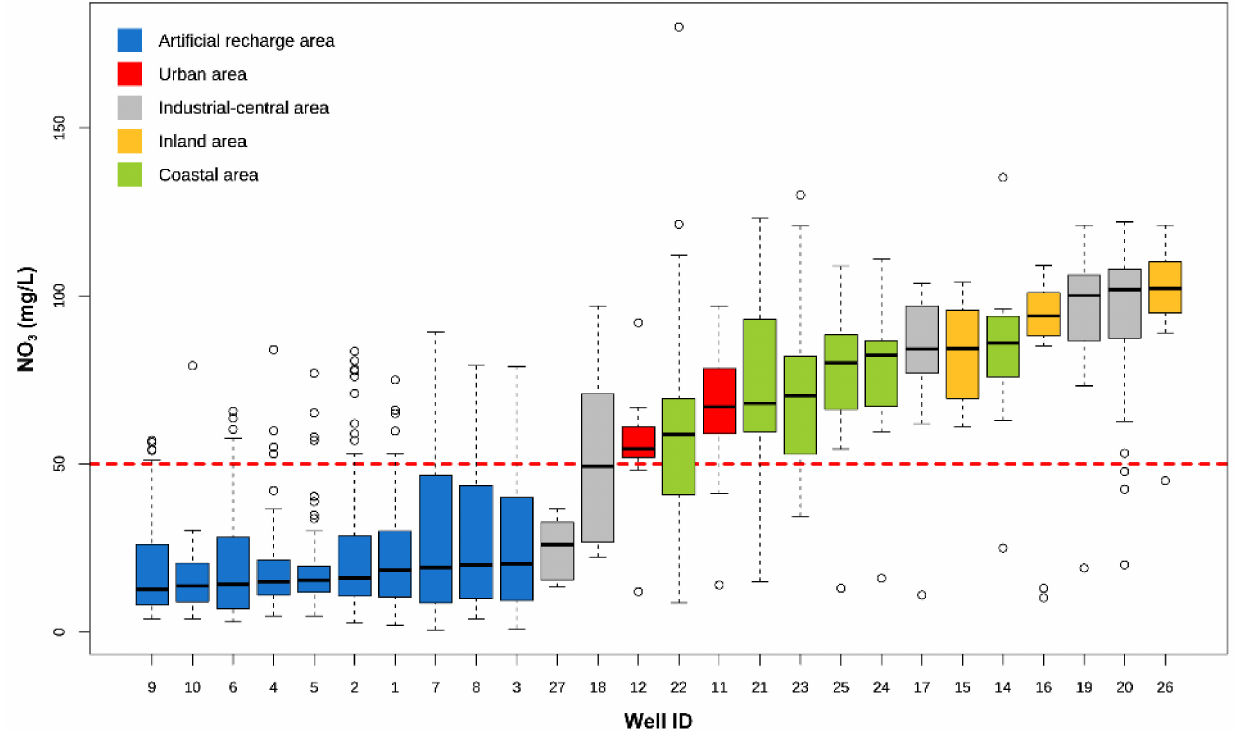
Figure 4. Boxplots of NO 3 − concentration in mg/L measured in the monitored wells and ordered according to increasing median values. The horizontal dotted red line marks the Law Limit of 50 mg/L defined by the Italian